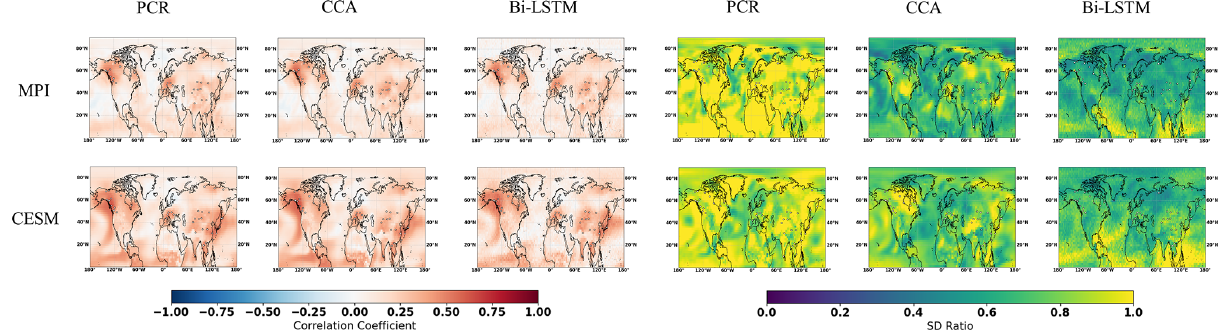
Figure 7. The same as Fig. 5 but for employing the full 48-pseudoproxy network with red noise